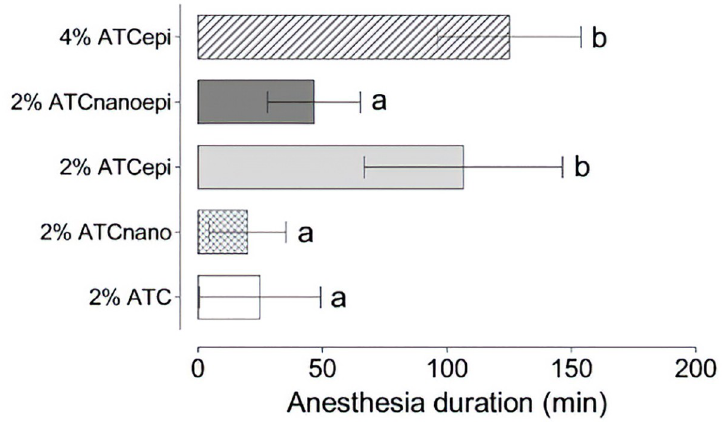
Fig 6. Analgesia duration (mean ± SD, in minutes) after subcutaneous injection. 2% articaine (2% ATC), 2% articaine-loaded poly( ε -caprolactone) nanocapsules (2% ATC nano ), 2% articaine with 1:200,000 epinephrine (2% ATC epi ), 2% articaine-loaded poly( ε -caprolactone) nanocapsules with 1:200,000 epinephrine (2% ATC nanoepi ), and 4% articaine with 1:200,000 epinephrine (4% ATC epi ) (n = 6 rats/group). ANOVA and LSD t-test: different letters indicate P <